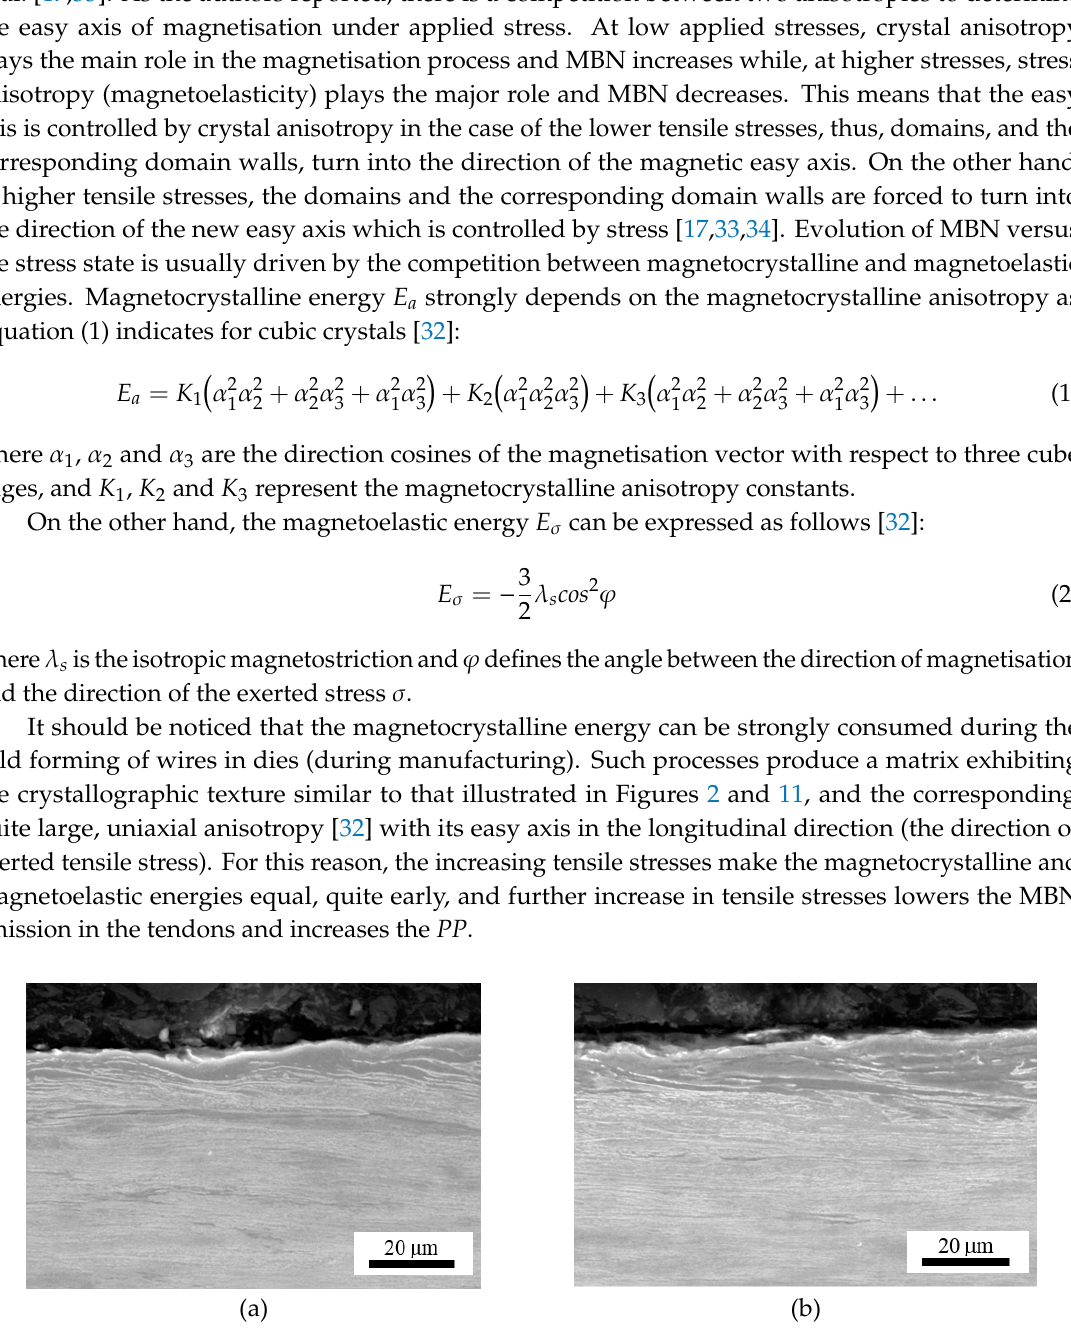
Figure 11. SEM images of preferential orientation of rope wire n.2. ( a ) Region 1; ( b ) region 2.